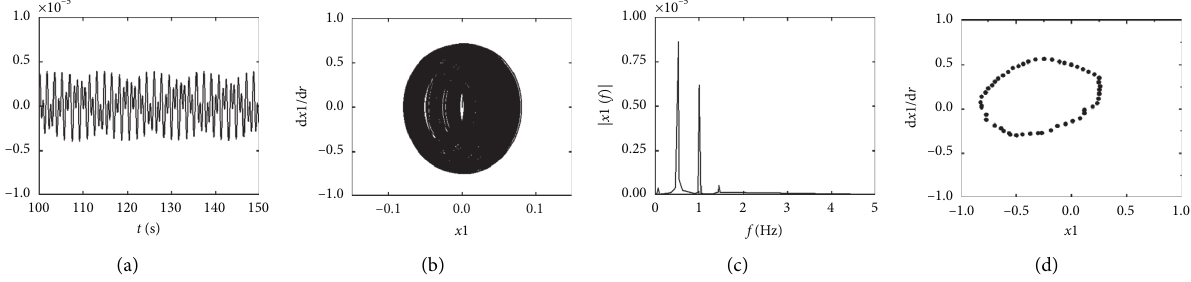
Figure 12: Numerical analysis results at ω � 2605rad/s, k and (d) Poincare map.